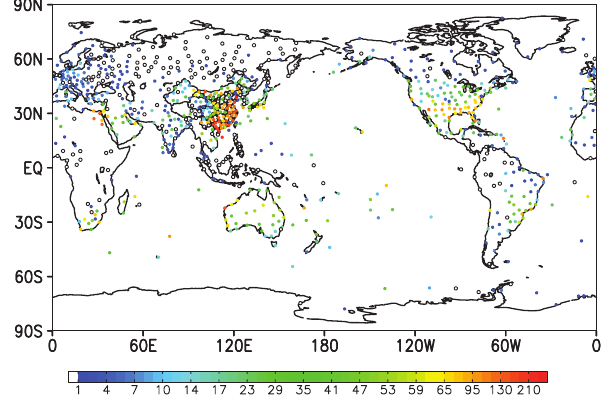
Figure 2. The total number of failed relative humidity observa- tions for each operational radiosonde station from December 2008 to November 2009. The colored dots correspond to values indicated by the color bar, and the black open circles denotes no humidity sensor failure